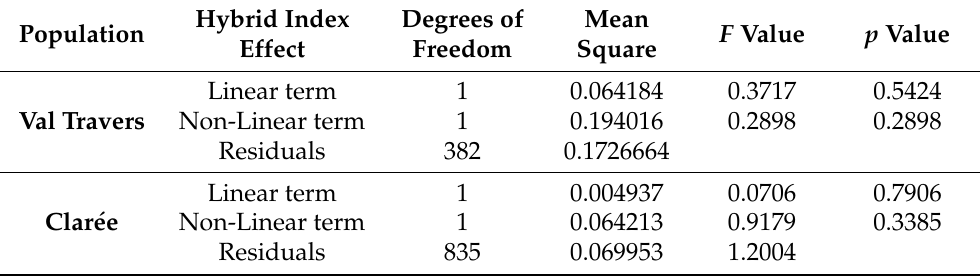
Table 3. ANOVA analysis of the linear models testing for the linear and non-linear effects of Hybrid Index on family sizes in Val Travers and Clar é e populations.